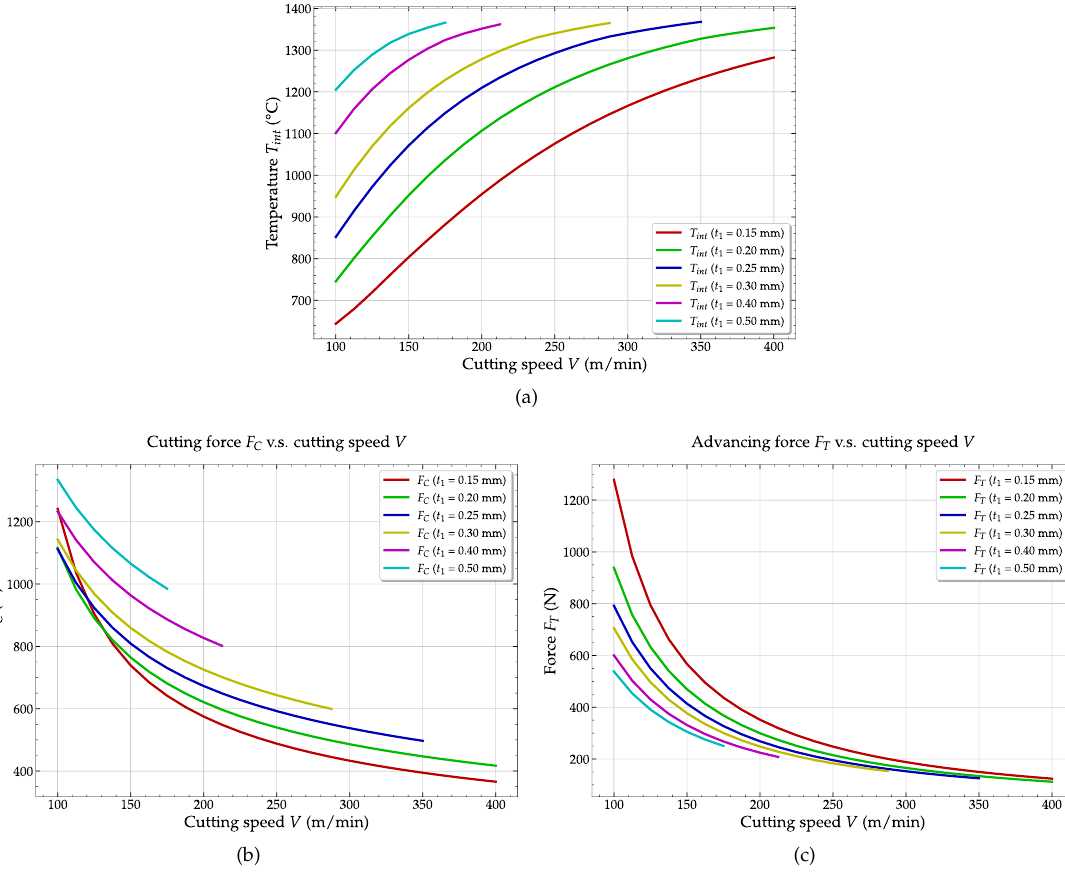
Figure 7. Interface temperature T int ( a ), cutting force F C ( b ), and advancing force F T ( c ) evolution vs. cutting speed V and depth of cut t 1